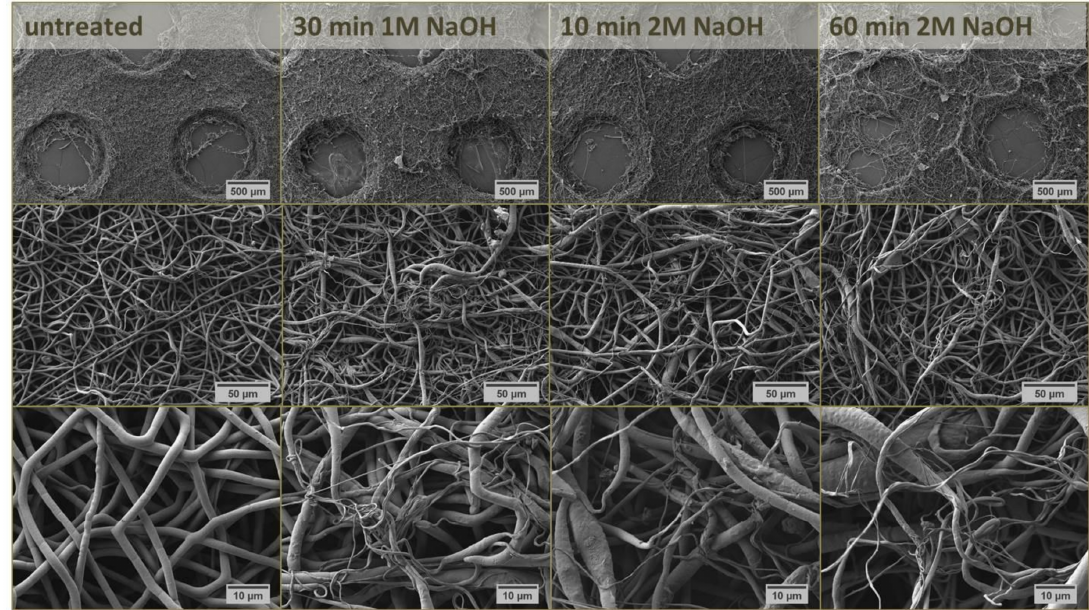
Figure 5. Scanning electron micrographs of SES scaffolds from PCL with round holes (Ø 1 mm) in alternating rows and a hole distance of 2 mm without treatment or after incubation for 10–60 min in 1.0 M or 2.0 M NaOH. Micrographs in the middle and bottom row are higher magnifications of the micrographs shown in the top row. Table 2. Contact angles of the surfaces of porous SES scaffolds from PCL without treatment or after incubation for 10, 30 or 60 min in 1.0 or 2.0 M NaOH. In case of (cid:7) marked scaffolds, no contact angle